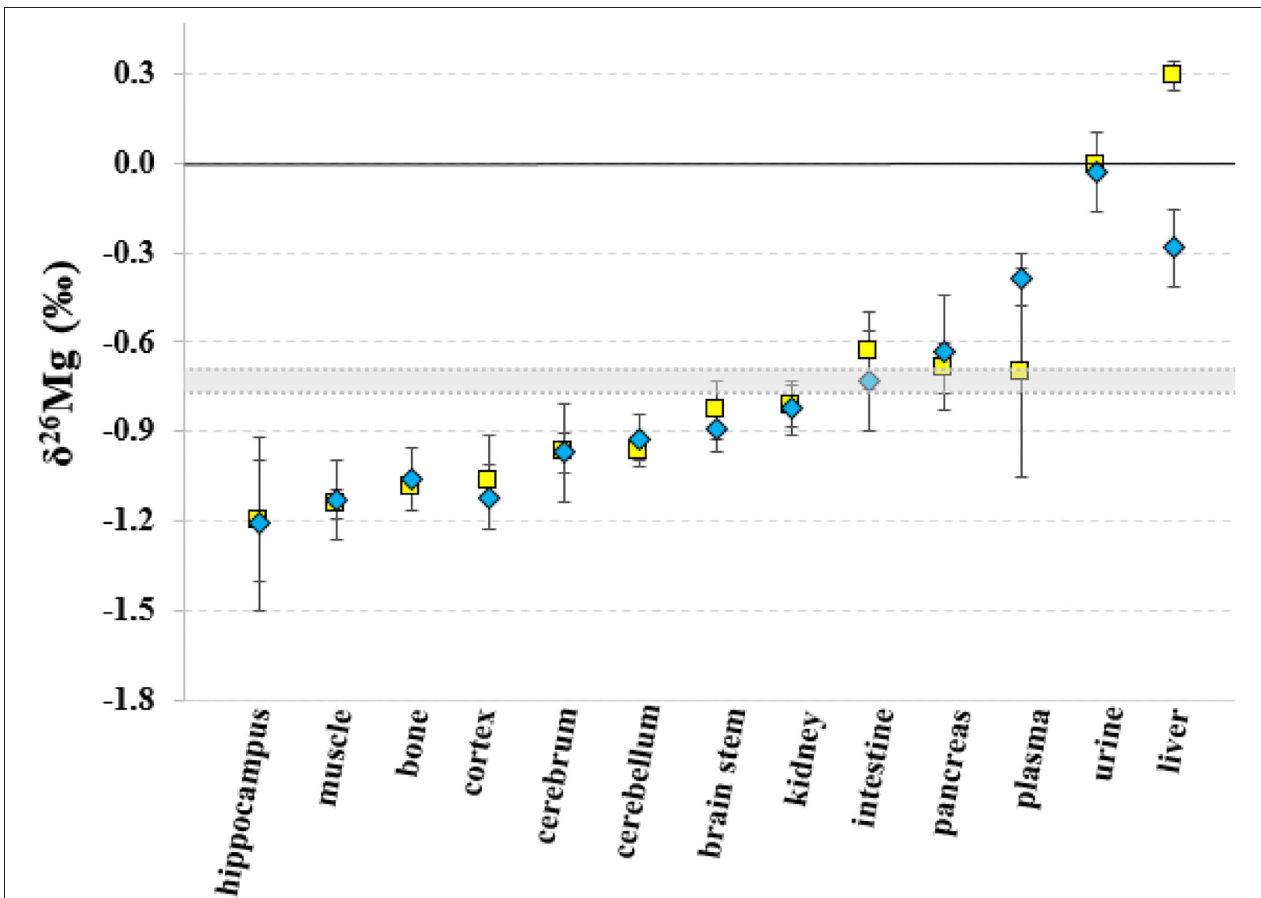
FIGURE 2 | Body distribution of the Mg isotopes in young controls and LPS-injected mice. Yellow squares correspond to the control mice, blue diamonds to the LPS-injected mice and the gray area corresponds to the Mg isotopic composition of the food. Error bars indicate the standard deviation.